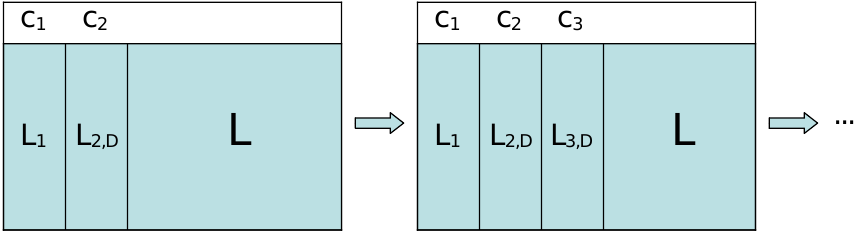
Figure 4 . First pattern of positive components: column-wise elimination.